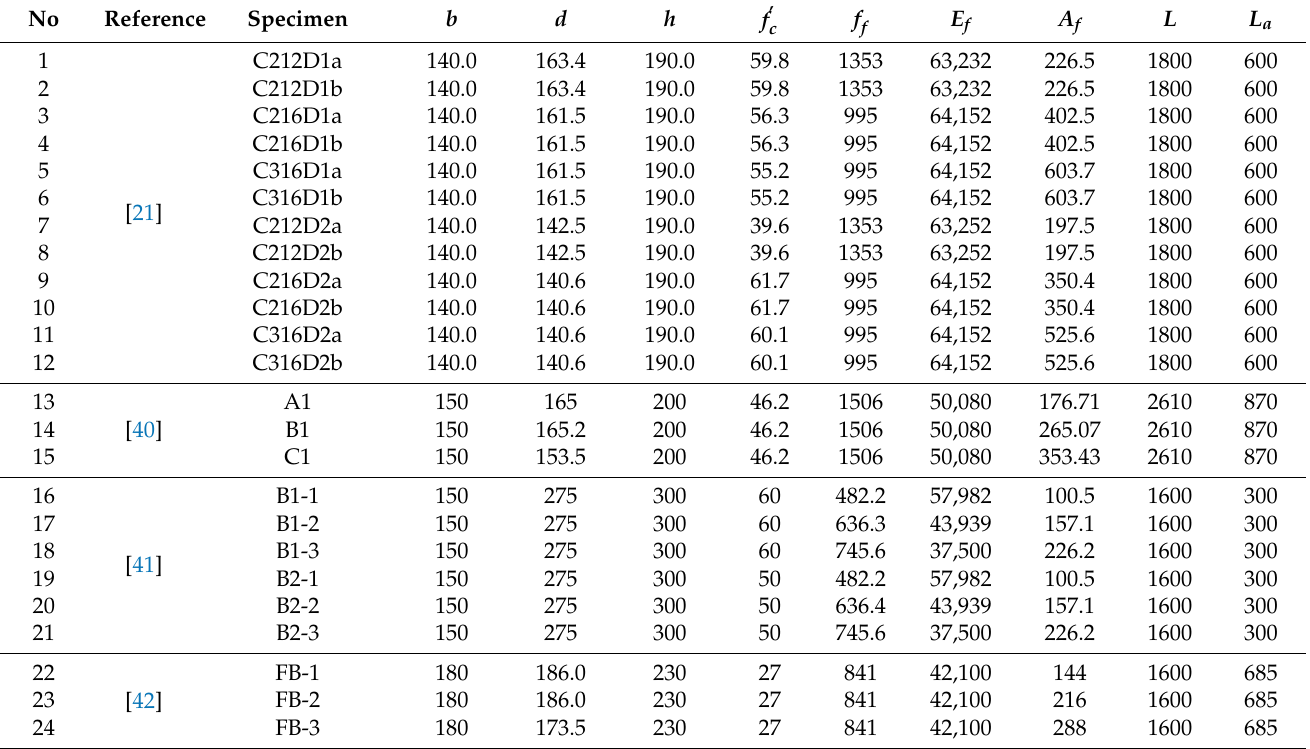
Table A1. Database of the experimental four-point flexural test for deflection of FRP-reinforced concrete